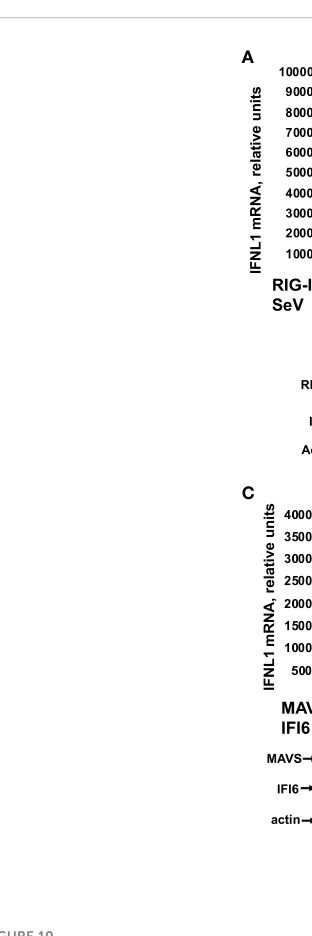
FIGURE 10 IFI6 affects RIG-I activation. (A) Human 293T cells were transiently co-transfected with the pCAGGS plasmids encoding IFI6-HA and RIG-I-FLAG, or with empty plasmids (E). Then, the cells were infected with SeV (MOI 3) during 24 h. Proteins in the cellular extracts from non-infected cells (bottom blots in A ) were subjected to Western blotting using antibodies speci fi c for FLAG tag (to detect RIG-I protein), the HA tag (to detect IFI6) or actin, as loading control. (B, D) Human 293T cells were transfected with two (B) or one (D) siRNAs speci fi c for IFI6 or with the NT siRNA and 24 h after siRNA-transfections, the cells were transfected with the pCAGGS plasmid encoding RIG-I-FLAG, or with the empty plasmid, as control. Then, the cells were infected with SeV (MOI 3) during 24 h. (C) Human 293T cells were transiently co-transfected with the pCAGGS plasmids encoding IFI6-HA and MAVS-FLAG, or with empty plasmids, during 24 h. Proteins in the cellular extracts from non-infected cells (bottom blots in C ) were subjected to Western blotting using antibodies speci fi c for the FLAG tag (to detect the MAVS protein), the HA tag (to detect IFI6) or actin, as loading control. (A – C) Total RNAs were extracted and the levels of IFNL1 were measured by RT-qPCR and mRNA levels were expressed as fold change (increases) in comparison to control cells, used as controls. Three different experiments were performed, with similar results. ***P<0.001, ****P<0.0001 (using Student ’ s t test). (D) Cellular extracts (input) were subjected to immunoprecipitation (IP) using an anti-FLAG antibody, to pull down RIG-I using af fi nity columns. Proteins in the cellular extracts and after IP were subjected to Western blotting using antibodies speci fi c for ubiquitin or the FLAG tag (to detect RIG-I protein). IB, immunoblot. Western blots after the IP were quanti fi ed by densitometry using ImageJ software, and the amounts of RIG-I ubiquitinated (RIG-I-ub) were normalized to the amounts of RIG-I (numbers below the blot). ND, not detected. Two independent experiments and Western blots were performed, with similar